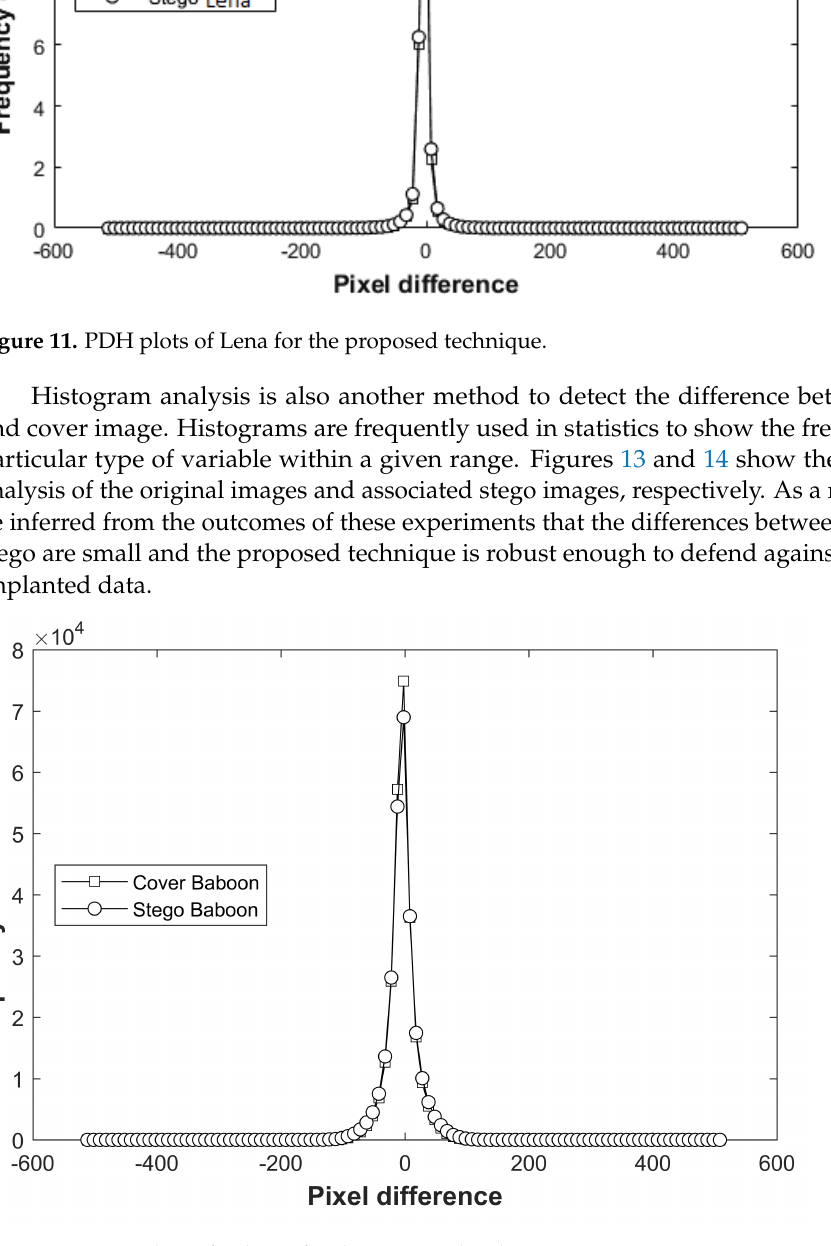
Figure 12. PDH plots of Baboon for the proposed